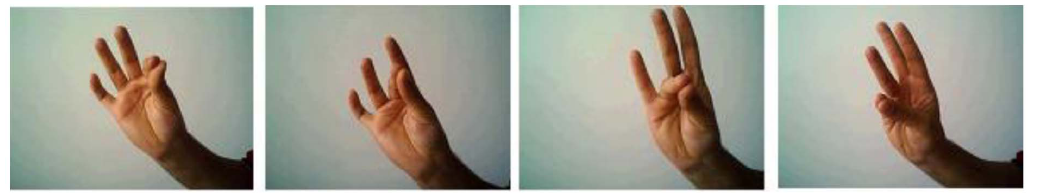
Figure 1. Frames of the videos which were presented to the participants. They show the performance of a precision grasp pantomime using the thumb and the rest of the fingers.